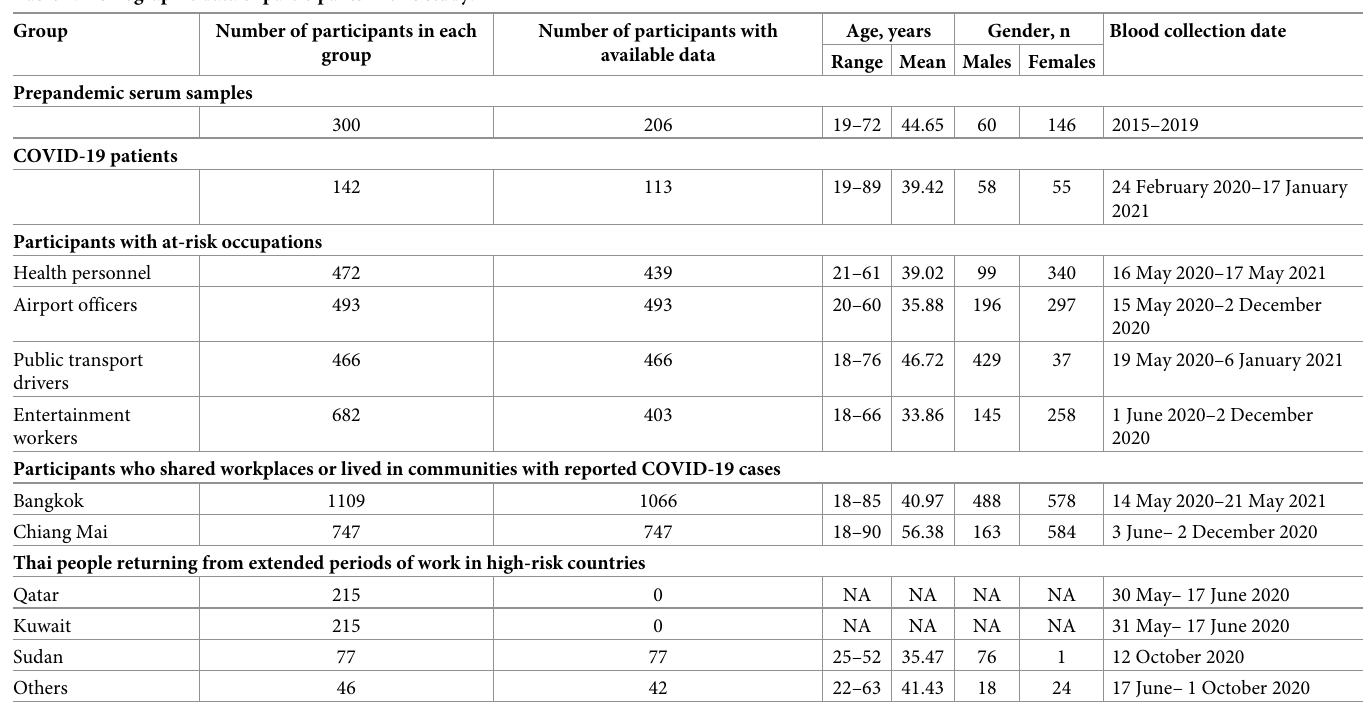
Table 1. Demographic data of participants in this